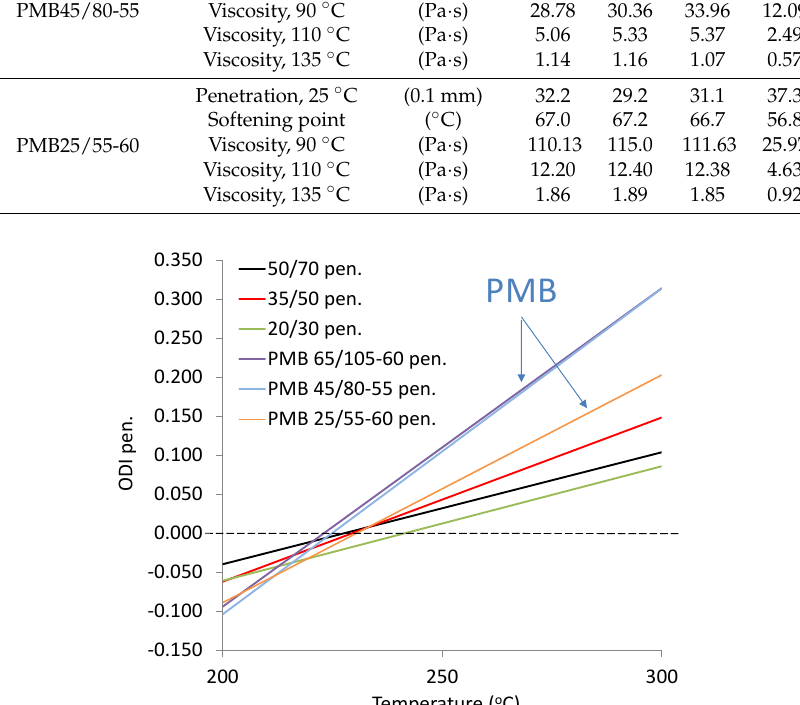
Figure 2. Comparison of sensitivity to overheating A (ODI) of non-modified and modified bitumens, based on an example graph for Overheating Degradation Index of penetration (ODI pen. ).